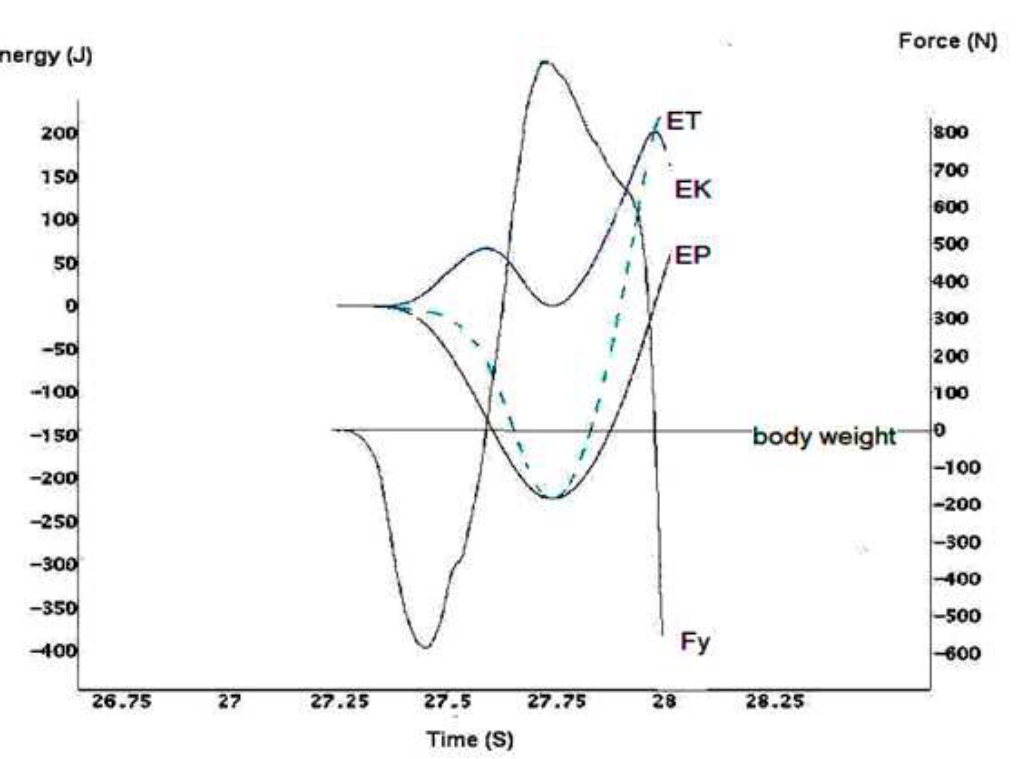
Figure 1. The mechanic energy variations considered to determine the positive and negative external working times, and the relation between the vertical force recording and the subject's weight during a CMJ. EK: kinetic energy, EP: potential energy and ET: total mechanic